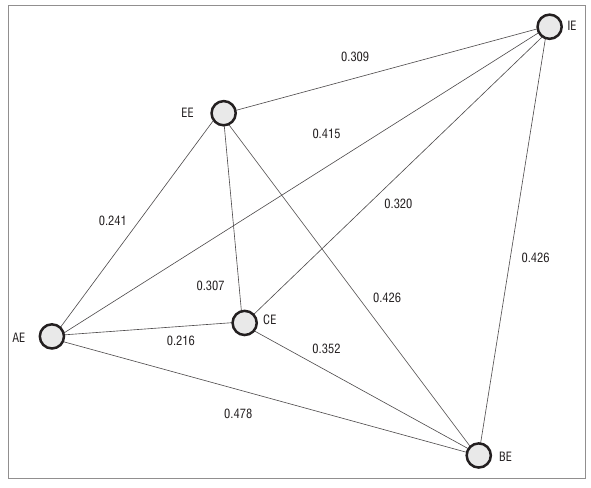
Figure 1: Graphical depiction of the average Bhattacharyya distances between the five accents of South African English: White South African English (EE), Indian South African English (IE), Black South African English (BE), Afrikaans English (AE) and Cape Flats English (CE).